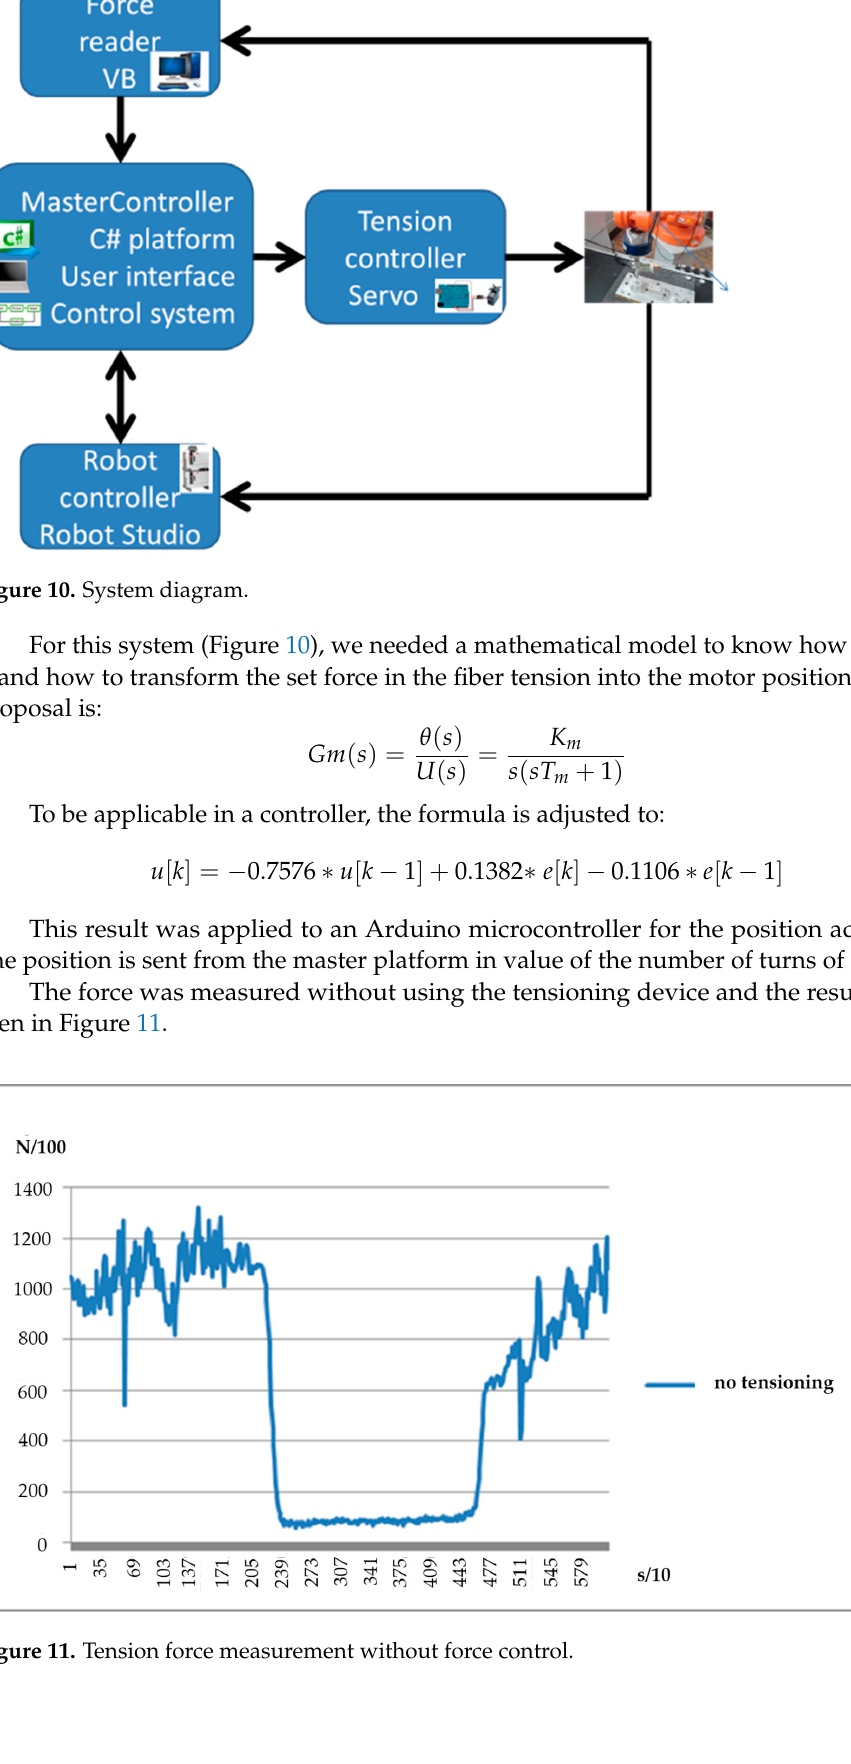
itself (Figure 10).